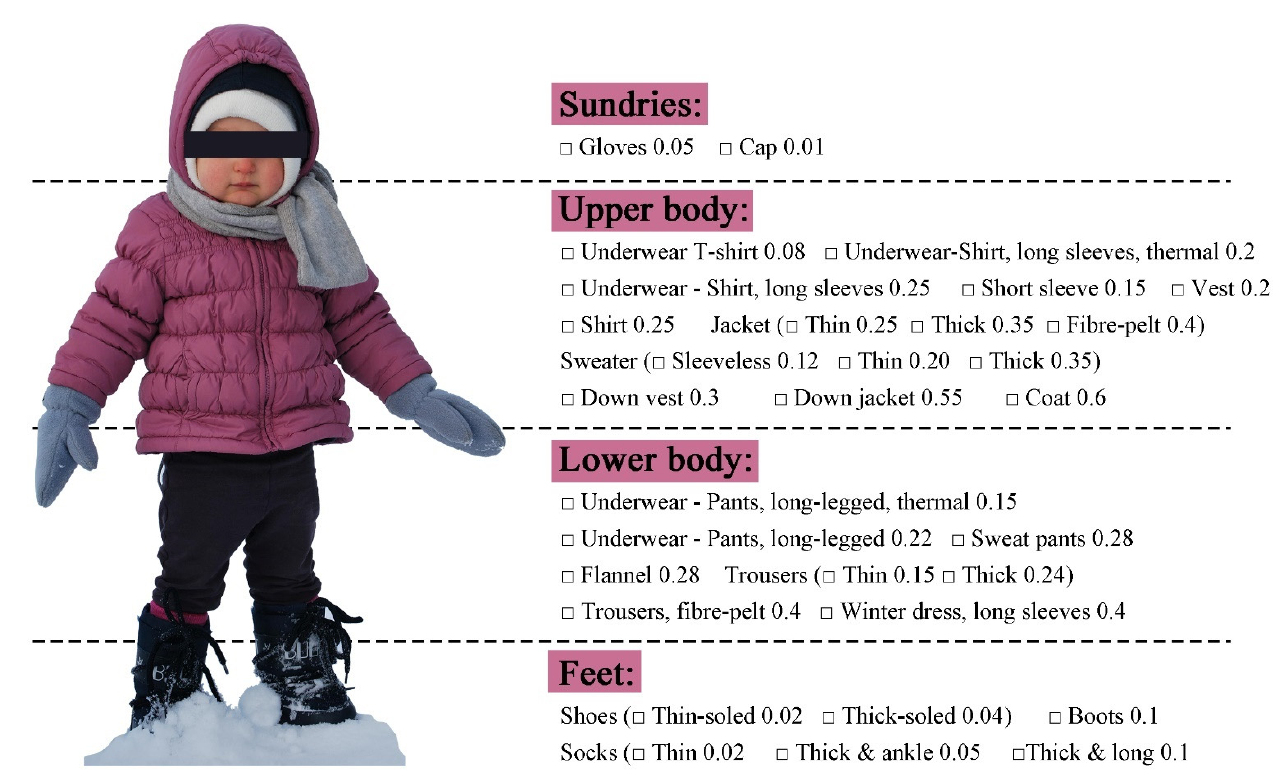
Figure 5. Simplified garment checklist. Table 2. Activity types, codes, MET, and modified metabolic value among physical activities inten- sity levels.